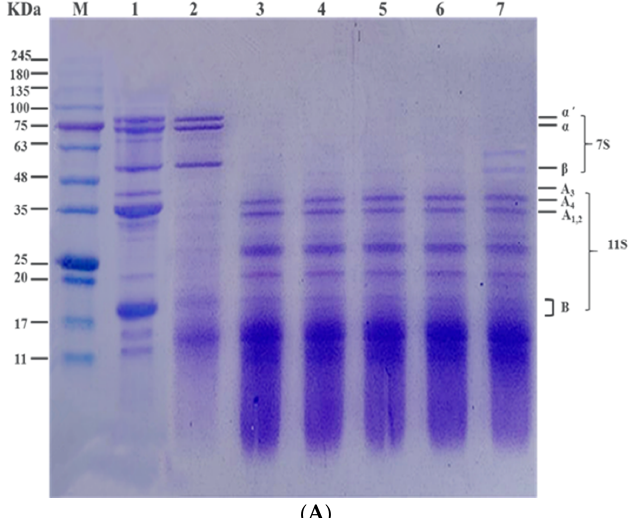
Table 1. Contents of the secondary structure prediction by Amide І bands and Fermi resonance ratio I 850 /I 830 and the number of tyrosine residues that are exposed/buried in heated